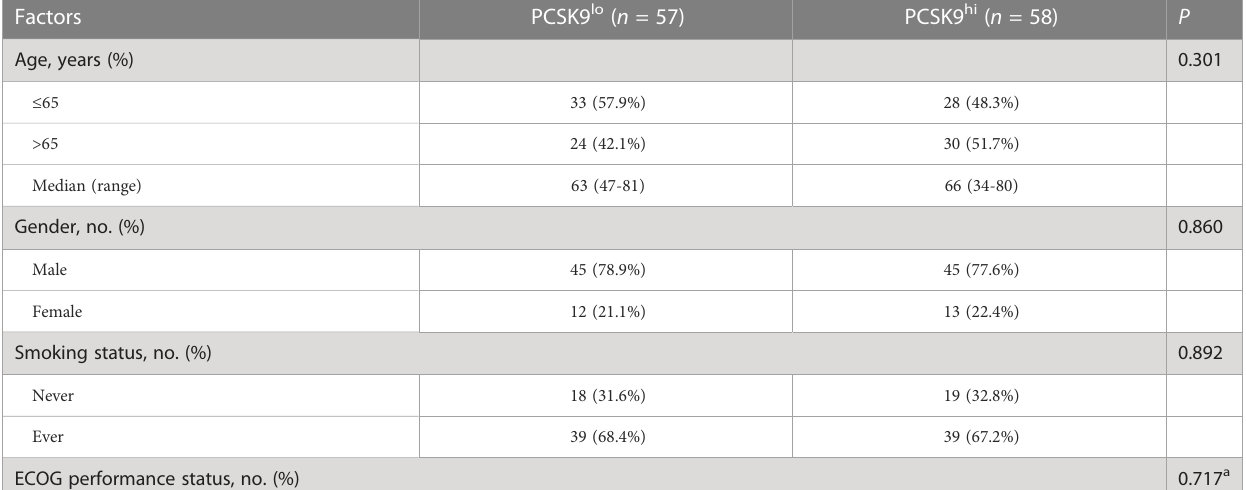
TABLE 1 Clinicopathological characteristics and factors of advanced NSCLC patients in the PCSK9 lo and PCSK9 hi groups. Factors PCSK9 lo ( n =